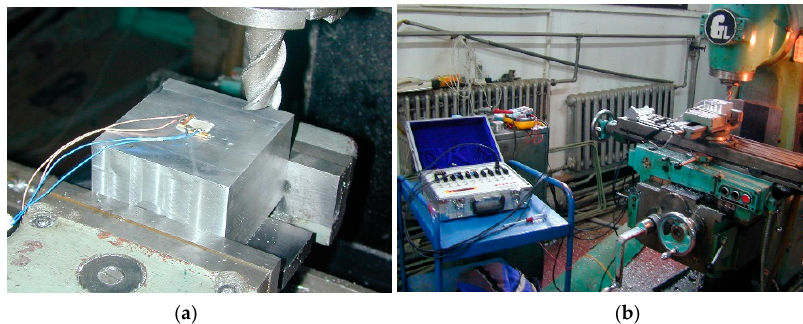
Figure 3. Quasi ‐ nondestructive test for measuring distribution of residual stress. ( a ) Strain gauges and wire connecting; and ( b ) test equipment.